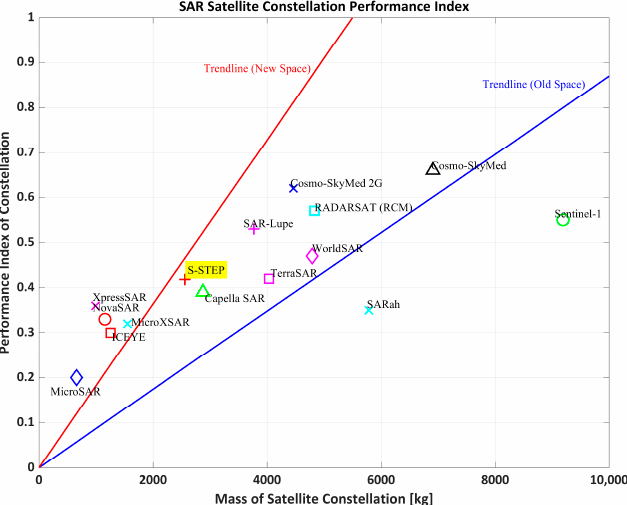
Figure 3. Comparison of the SAR performance indices as functions of satellite constellation masses.